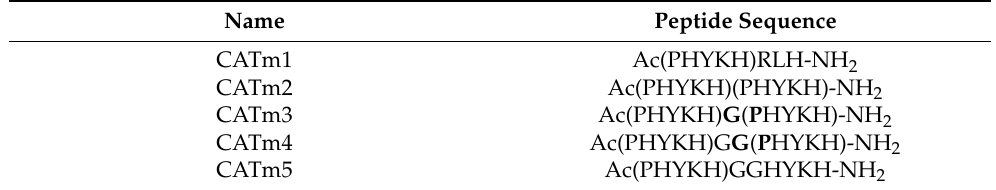
Table 1. Sequence of the peptidyl ligands studied. In bold are highlighted residues that may favor a turn